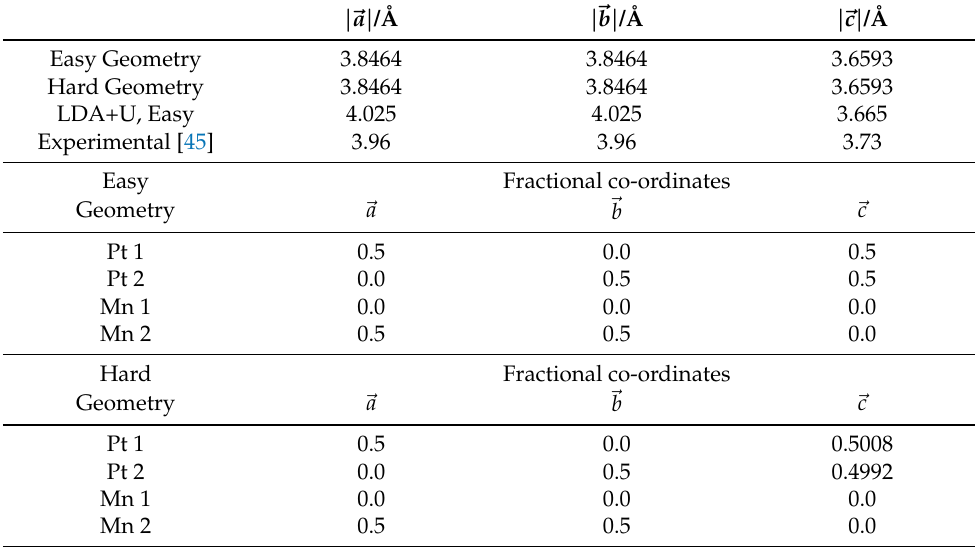
Table 3. Lattice parameters and atomic positions for relaxed PtMn dependant upon the different spin